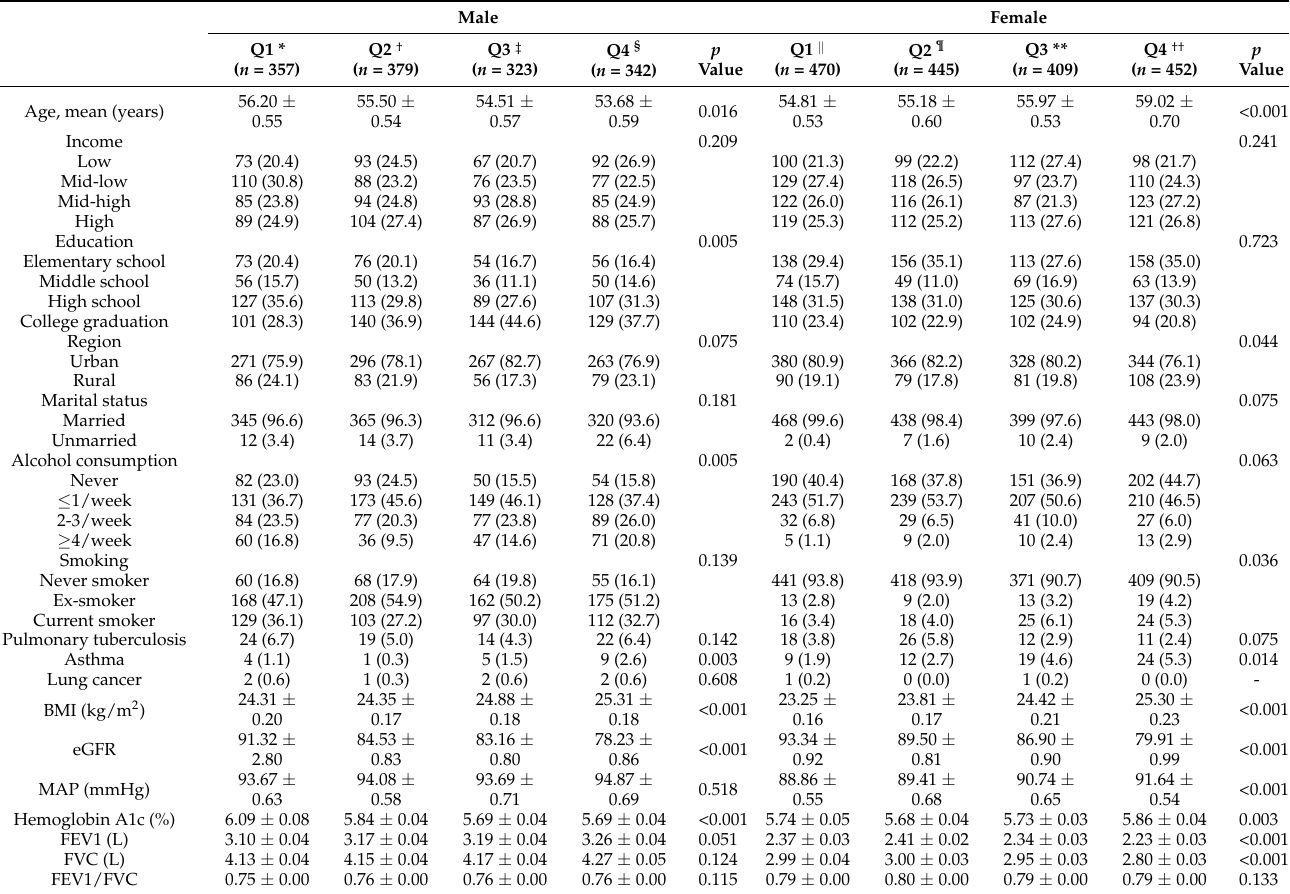
Table 2. Clinical and demographic characteristics according to serum uric acid